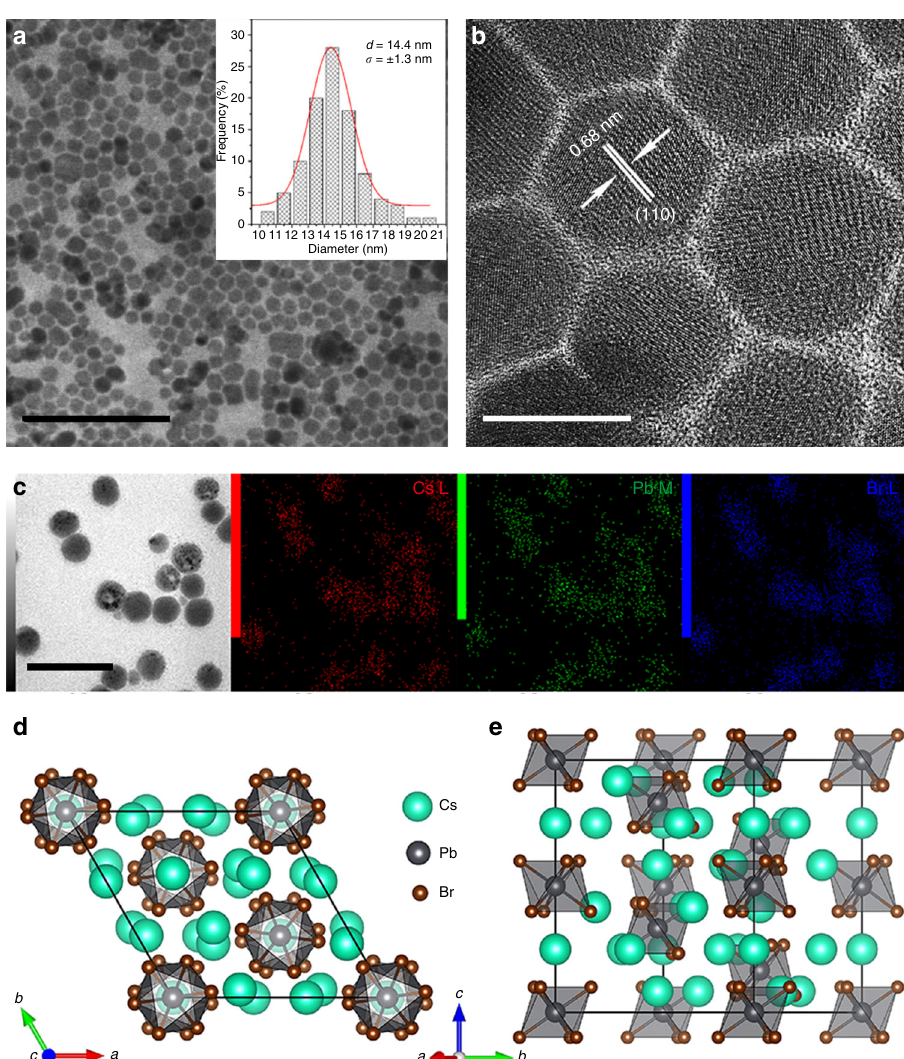
Fig. 1 Structural characterization of Cs 4 PbBr 6 NCs. a TEM image and the corresponding size distribution of as-prepared Cs 4 PbBr 6 NCs with Gauss fi tting, given in the inset. b High-resolution TEM (HRTEM) image of Cs 4 PbBr 6 NCs before compression. Scale bars are 100 nm in the TEM image and 10 nm in the HRTEM image. c HAADF-STEM image and elemental mapping (Cs, Pb, and Br) of the as-prepared Cs 4 PbBr 6 NCs (scale bar is 50 nm). Schematic crystal structure of Cs 4 PbBr 6 along ( d ) and perpendicular ( e ) to